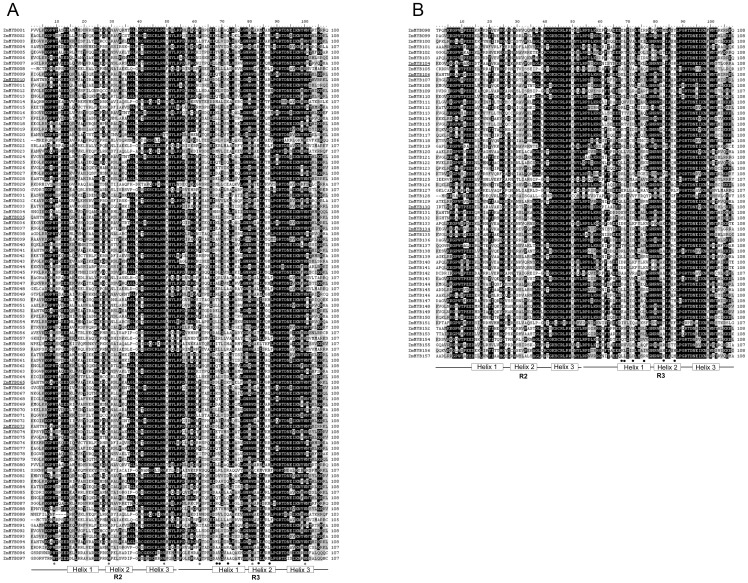
ClustalW amino acid sequence alignment of 157 typical maize R2R3-MYB domains.The shading of the alignment represents different degrees of conservation among sequences; the dark shading indicates identical residues, the light shading indicates conservative changes. The asterisks indicate conserved tryptophan residues (W) in the MYB domain. The positions of the three α-helices that form each MYB repeat are marked as Helix 1 to Helix 3. Residues involved in interaction are marked with dots; genes with these residues are underlined.